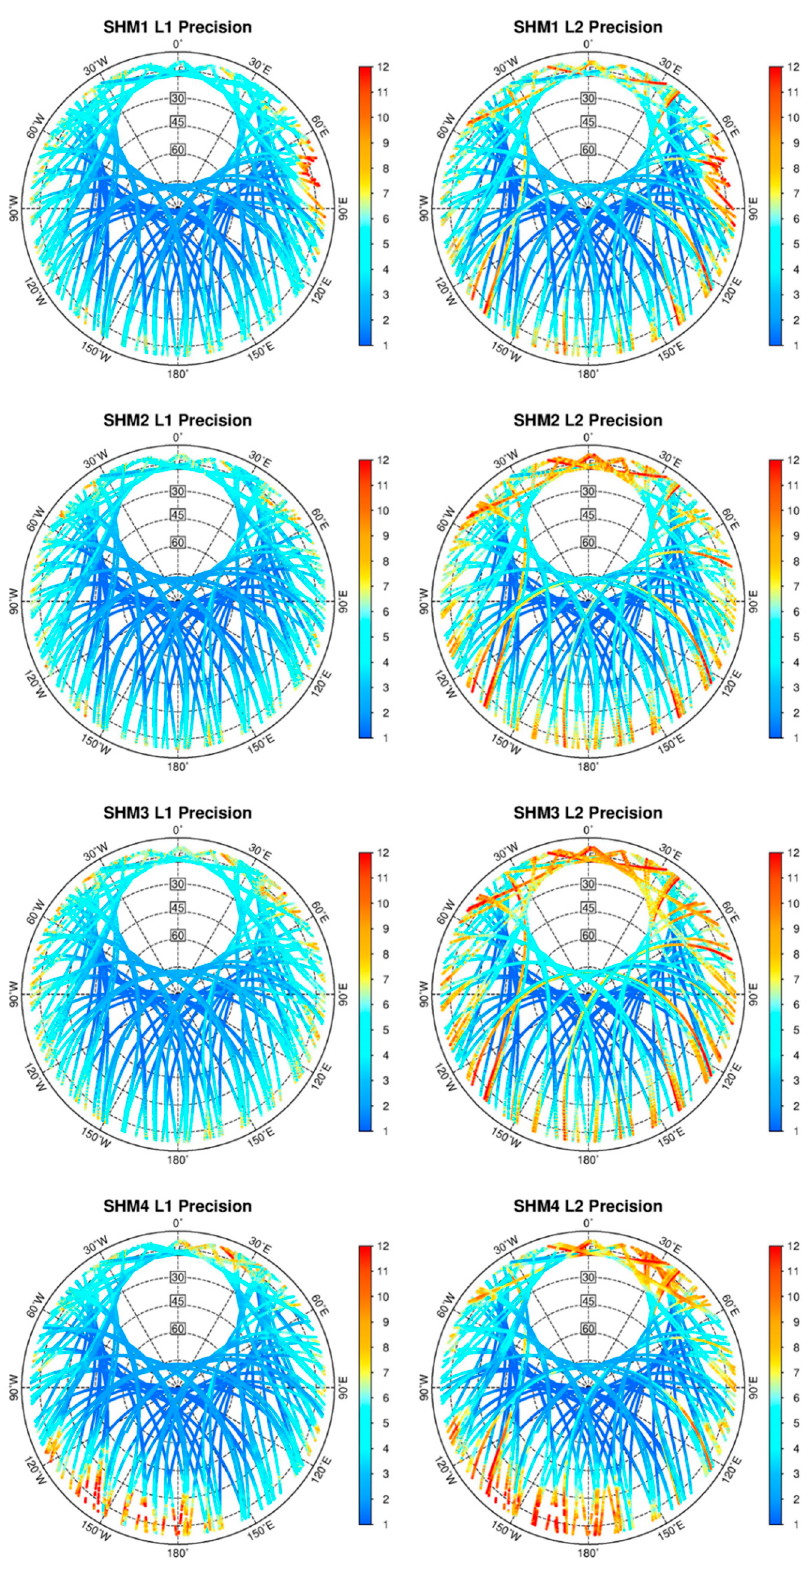
Figure 15. Precision sky-plots of GeoSHM stations.